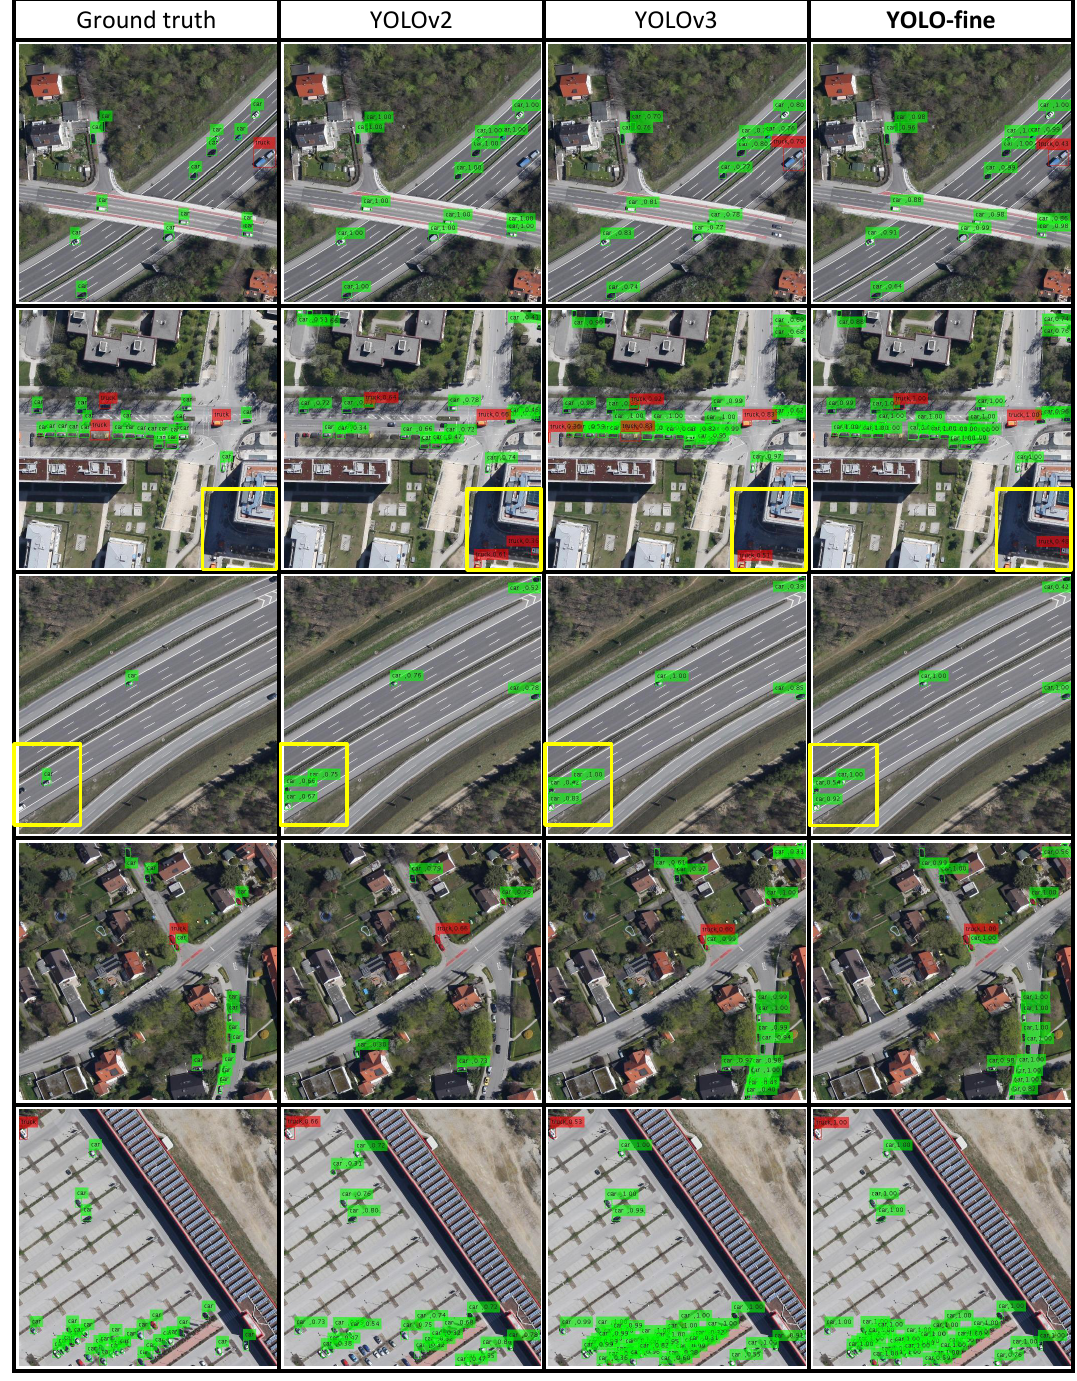
Figure 9. Illustration of detection results on